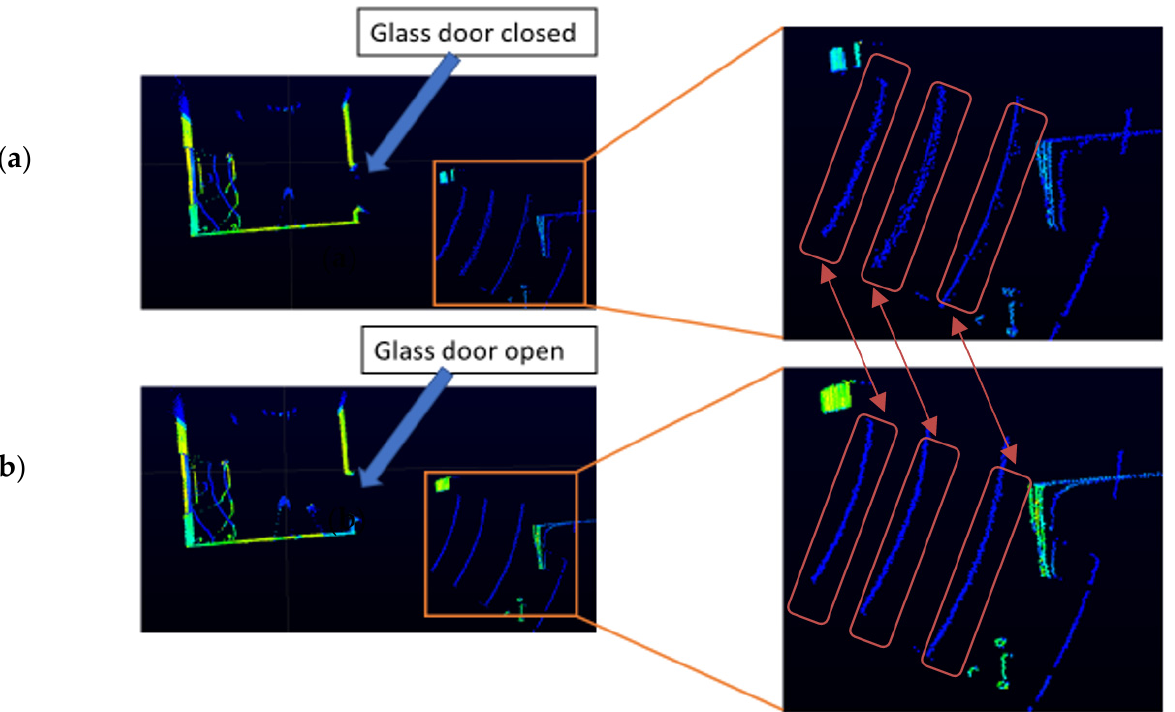
Figure 3. Displays image of LiDAR (light detection and ranging) distance measurements that are color coded by intensity (i.e., calibrated reflectivity). These measurements are collected in a room containing a glass door. ( a ) is collected while the glass door a is closed, and ( b ) is collected while the glass door is open. Both of these data are collected whilst the robot is at the same origin. The area detected behind the glass door is displayed in the orange box and the zoomed image of the red box is displayed in the right side of the image. As shown in the zoomed part of ( a , b ), the consecutive laser pluses distance measurement does not follow a similar pattern when the glass door is opened and closed. Looking closely, the three red boxes in ( a , b ) show the variation of distance measurement of neighbouring point clouds. The distance measurement of neighbouring lasers that passes through glass and hits the floor (when the glass door is closed) shows a relatively higher variation in the range measurement than when the point clouds when the glass door is open.